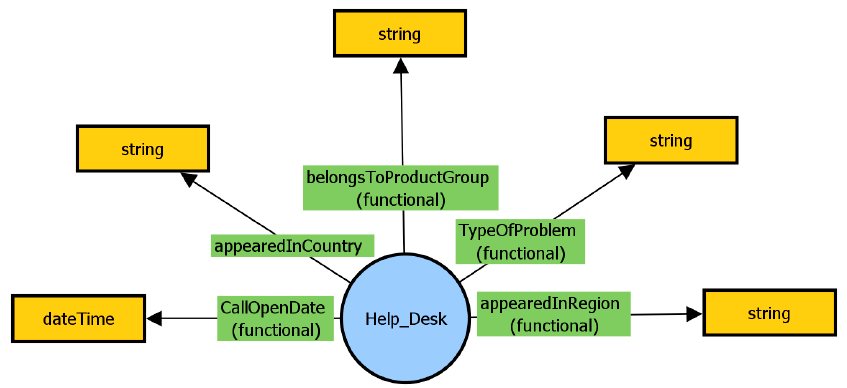
Figure 8. An ontology representing the information needs.